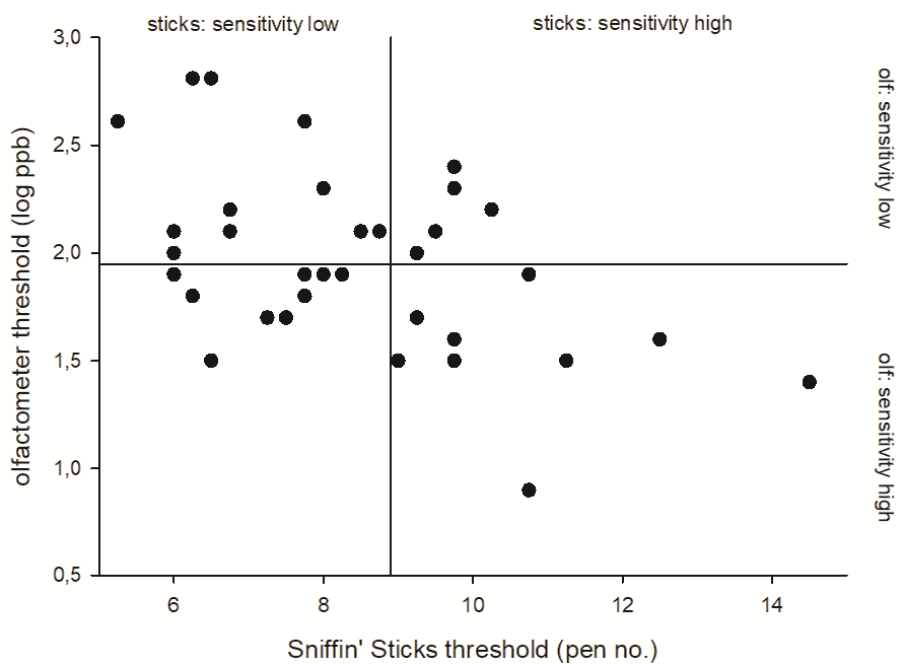
Figure 2. Scatter plot depicting the association between n-butanol Sniffin ’ Sticks- and olfactometer-derived thresholds. Note that in the Sniffin ’ Sticks test, a higher pen number corresponds to a higher n-butanol dilution and thus a lower threshold (higher sensitivity). Vertical and horizontal lines depict the respective cut-off values for high vs. low sensitivity groups (for details see text).